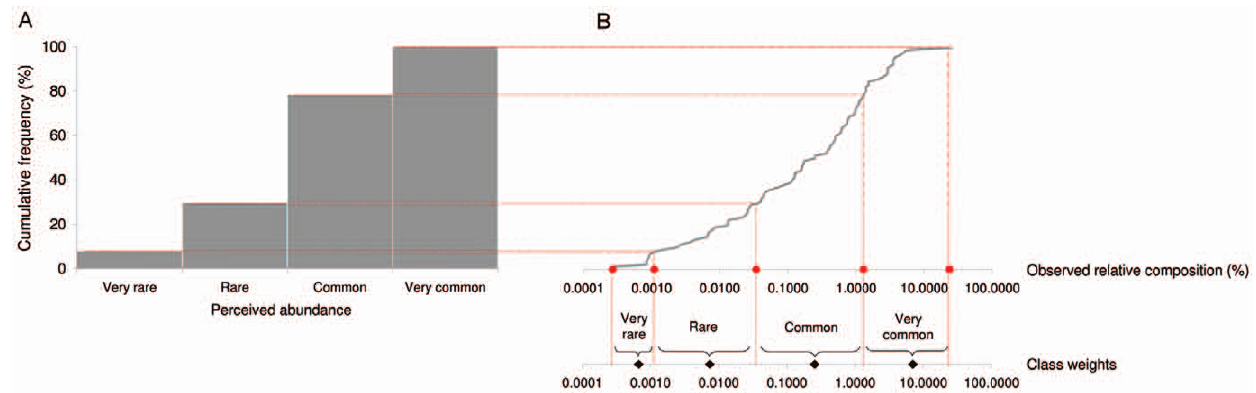
Figure 2. Intercalibration between qualitative (perceived abundance) and quantitative (observed relative composition) data in the period 1901–1925. (a) Cumulative frequency distribution of the number of species against qualitative classes of perceived abundance; (b) cumulative frequency distribution of the number of species against quantitative observed relative composition. Red dots represent the class limits that subdivide the species into four groups whose cumulative frequency distribution is the same of the frequency distribution of naturalists’ classes of perceived abundance. Black dots represent the class weights associated to each class of perceived abundance.